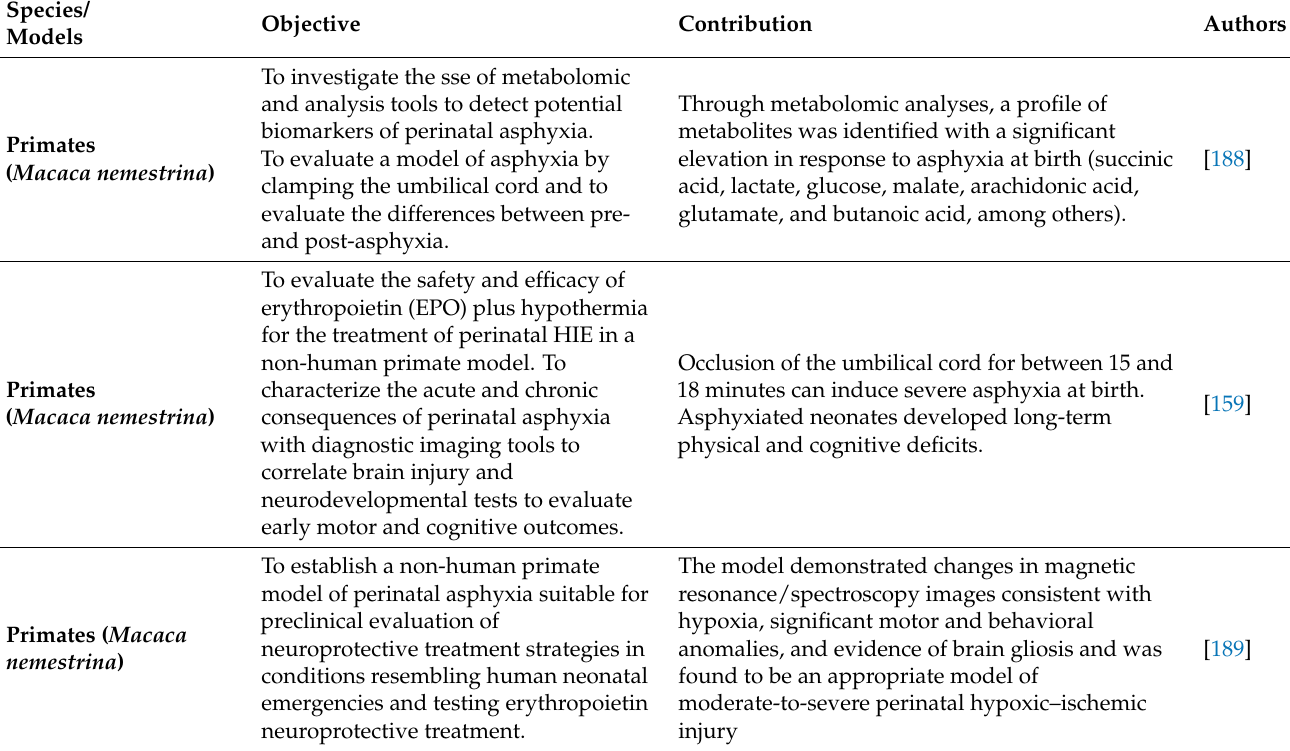
Table 4. Relevant findings of studies related to perinatal asphyxia in